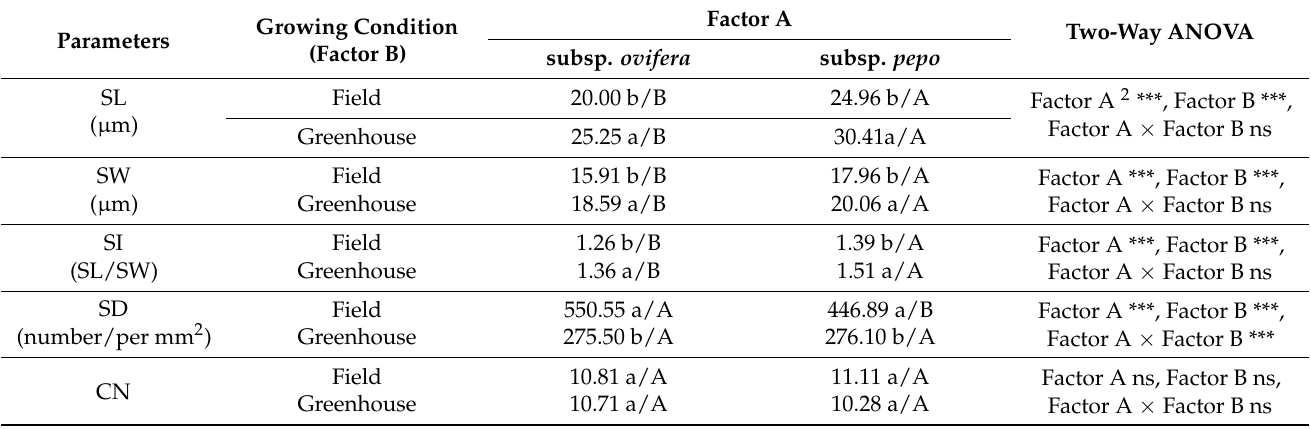
Table 1. Parameters of abaxial epidermis in donor C. pepo plants grown under different